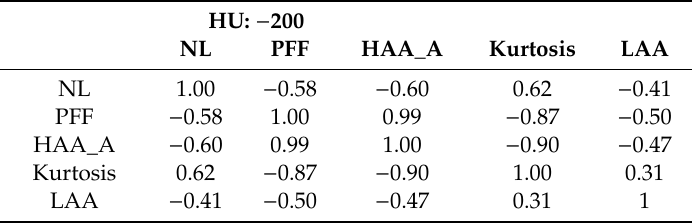
Figure 4. Pairwise scatter plot matrix, and correlation coe ffi cients ( ρ ) of HRCT histogram indices including NL, PFF, HAA_A, kurtosis, HAA, LAA at − 200 (left), 0 (right), and 200 (centre) HU. HAA, being defined as the areas with attenuation values greater than − 200 HU, is not shown in the first matrix. In NL, PFF, HAA_A, HAA, LAA parameters, the ‘%’ has been omitted for ease of reading. Table 3. Correlation matrix of HRCT histogram indices including NL, PFF, HAA_A, kurtosis, and LAA at − 200 HU threshold. HAA, defined as the areas with attenuation values greater than − 200 HU, is not shown. In NL, PFF, HAA_A, HAA, LAA parameters, the ‘%’ has been omitted for ease of reading.